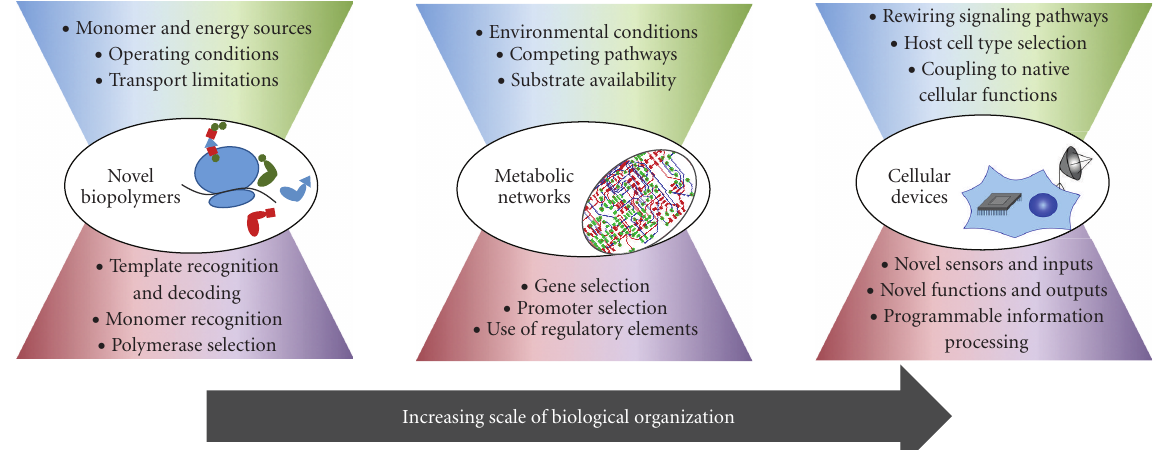
Figure 2: Application of the general framework to specific design objectives. At each scale of biological organization, designing synthetic biological systems invokes unique instances of the top-down and bottom-up considerations described in Figure 1.